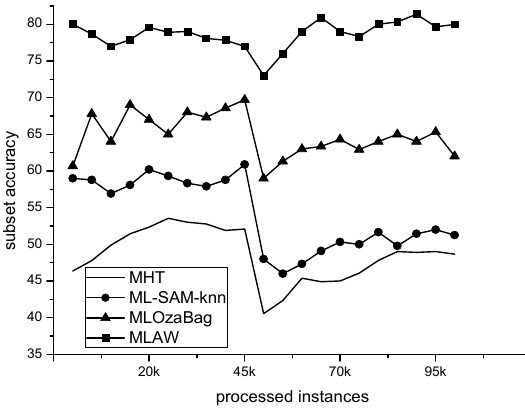
Figure 5. Subset accuracy on Random